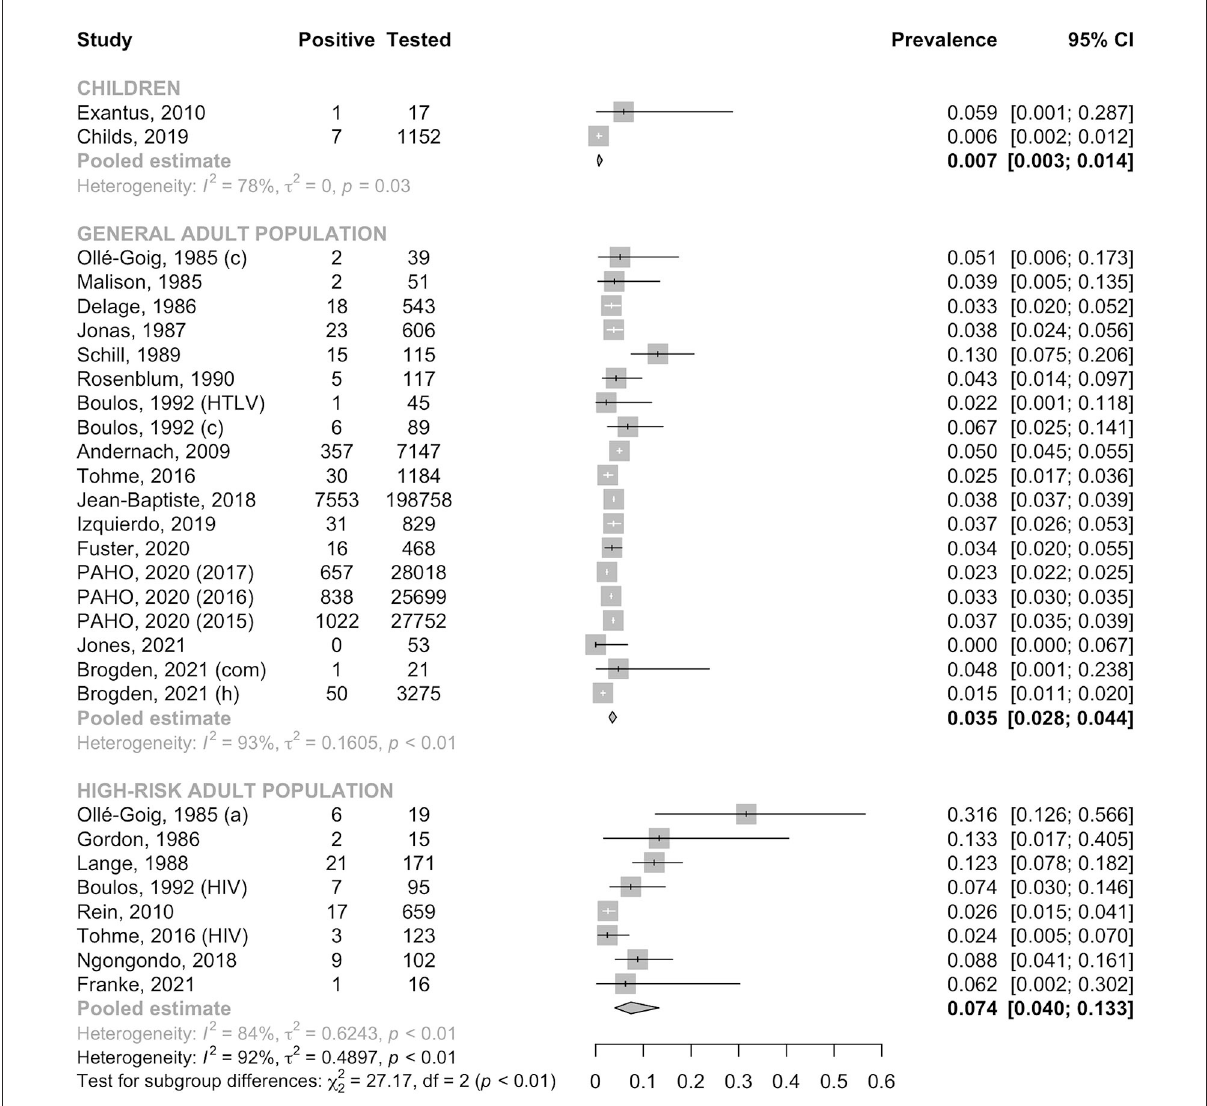
FIGURE2 Prevalence of HBsAg in children, the general adult population and the high-risk adult population. a, ascites group; c, control group; com, community recruitment; h, hospital recruitment; HIV, human immunodeficiency virus positive group; HTLV, human T-cell lymphotropic virus positive group; PAHO, Pan American Health